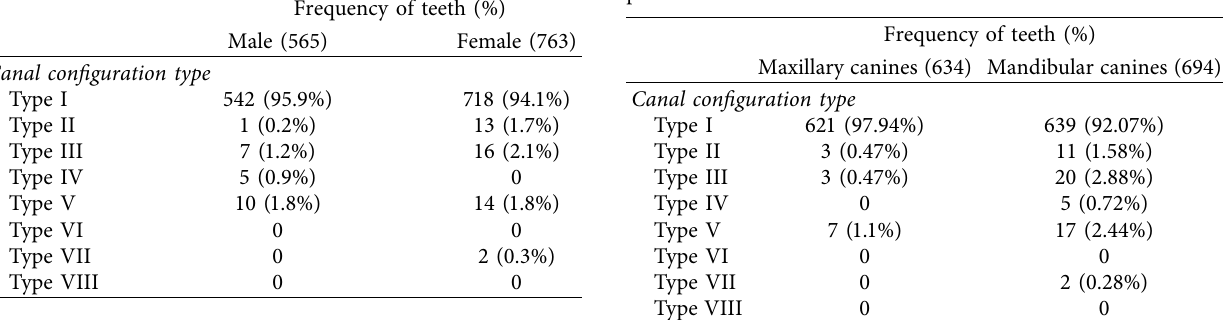
Table 2: Variations in canal configuration according to gender. Table 3: Variations in canal configuration according to tooth